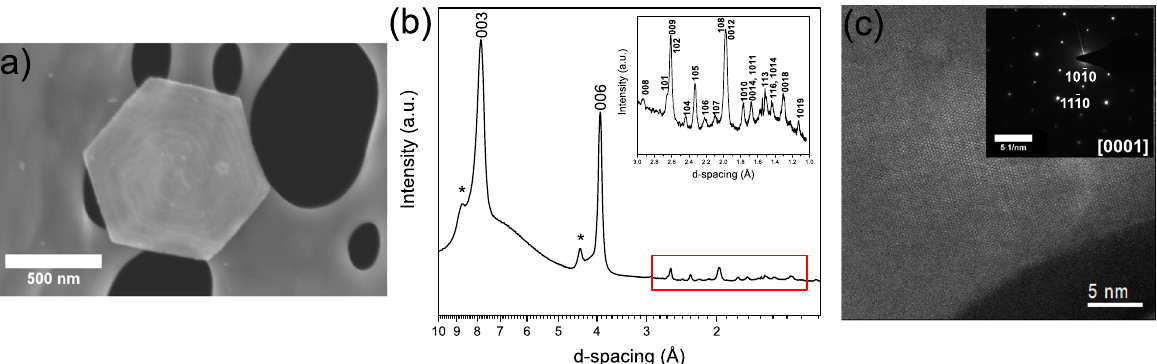
Fig. 1 Structural characterization of NiFe LDH hexagonal platelets. a SEM micrograph, b Mo K α -source XRD diffraction pattern (inset, zoomed signals for the 1.3-3 Å d-spacing region), c atomic-resolution HAADF-STEM (inset, SAED pattern) for as-synthesized NiFe LDH. Scale bars are a 500 nm, c 5 nm and inset, 5